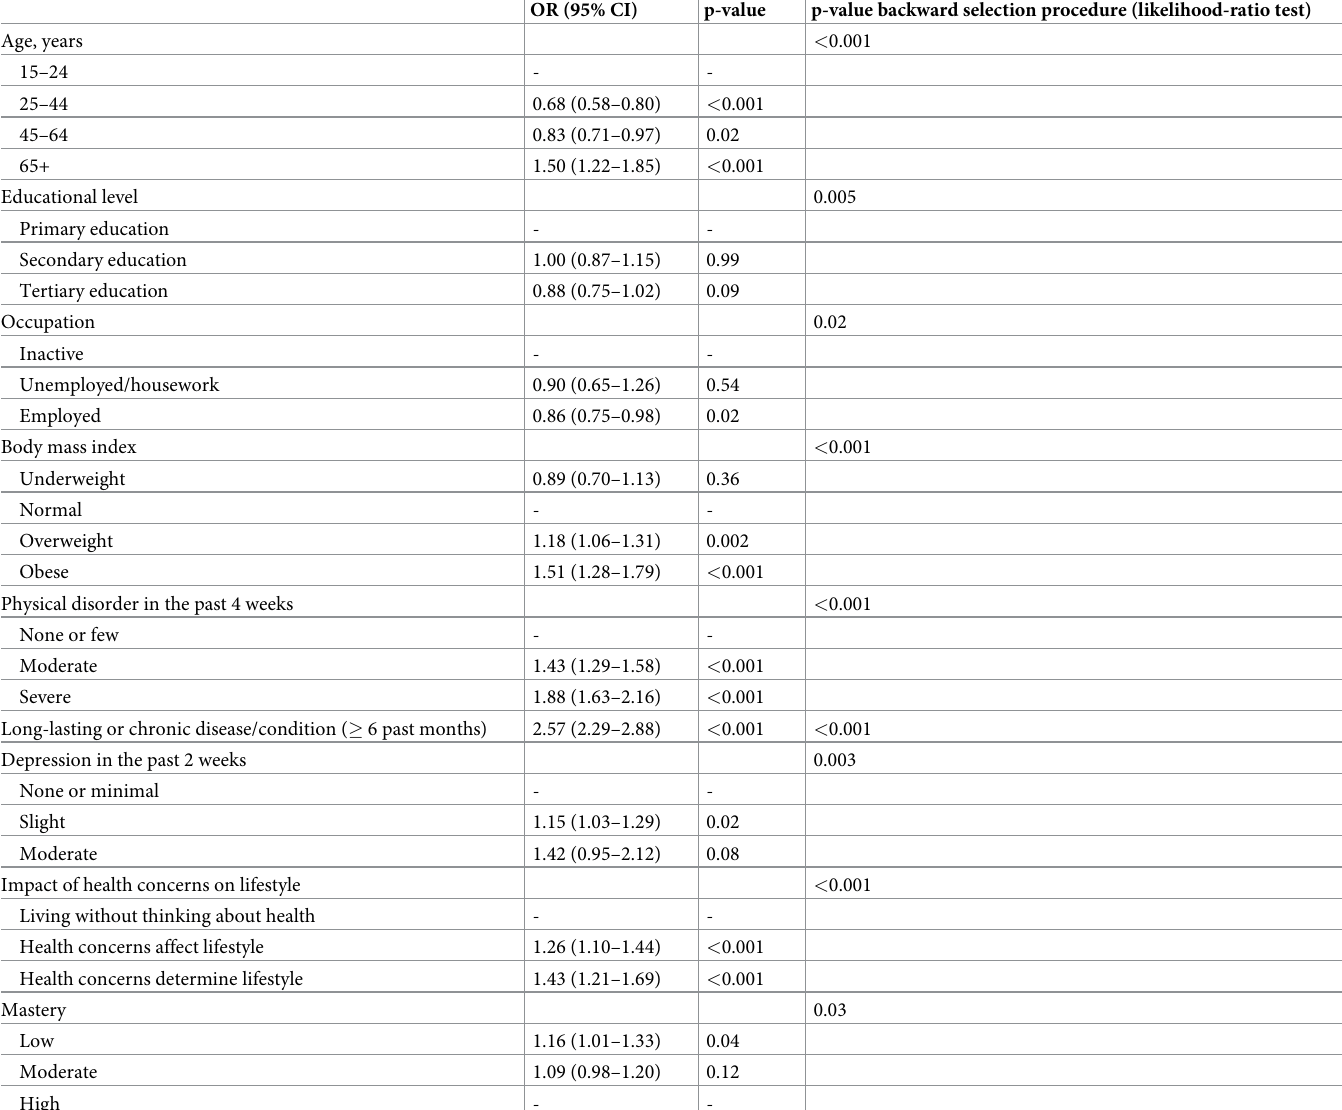
Table 9. Determinants of consultation with general practitioner using multivariate logistic